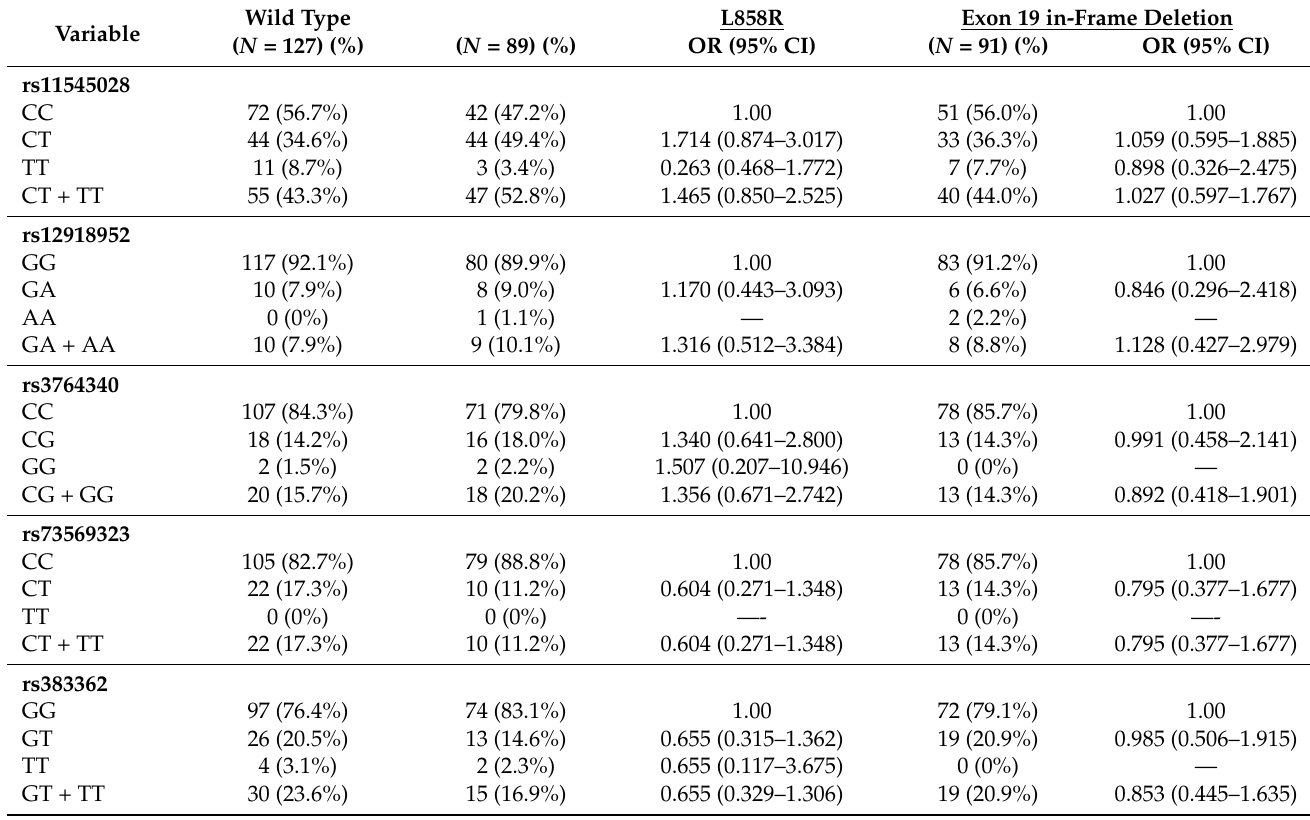
Table 3. The associations between the polymorphisms of WWOX and the EGFR hotspot mutations in lung adenocarci- noma